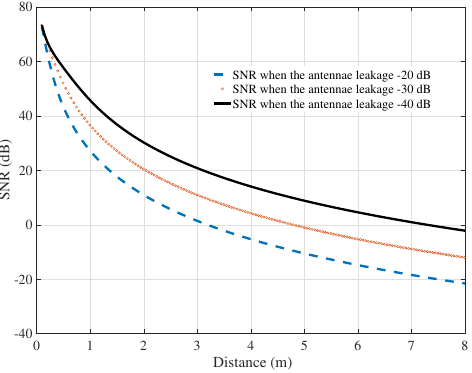
Figure 3. Signal-to-noise ratio (SNR) versus the distance from the radar system to the human body.